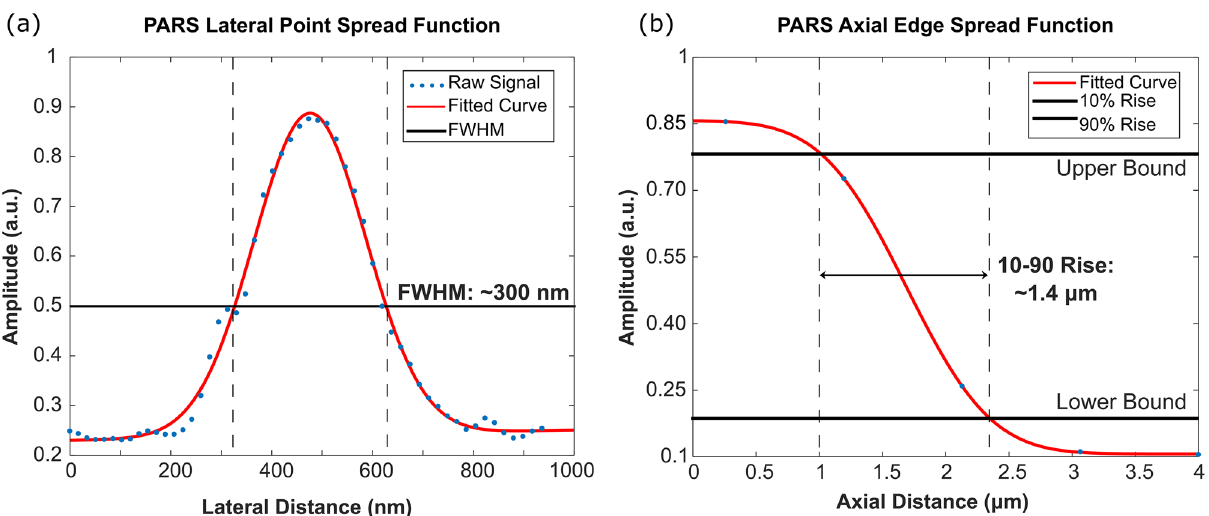
Figure 3. Imaging performance of the PARS subsystem. ( a ) Lateral PSF of the UV-PARS absorption contrast mechanism characterized by imaging 200 nm gold nanoparticles. PARS lateral resolution is measured to be ~ 300 nm. ( b ) Axial edge spread function of the UV-PARS absorption contrast mechanism modeled from volumetric imaging of cell nuclei. PARS axial resolution is determined to be ~ 1.4